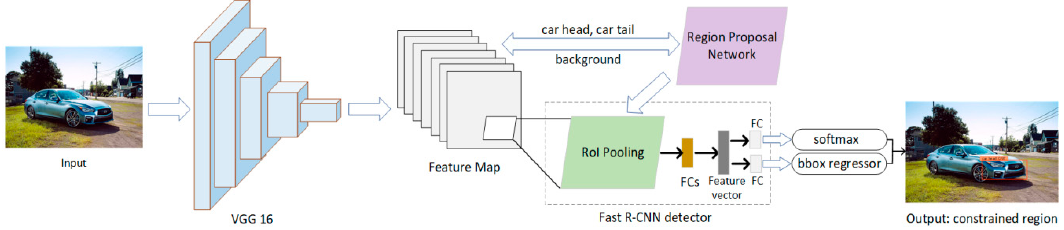
Figure 2. Our network of constrained region detection, include VGG16, region proposal network and Fast R-CNN detector.